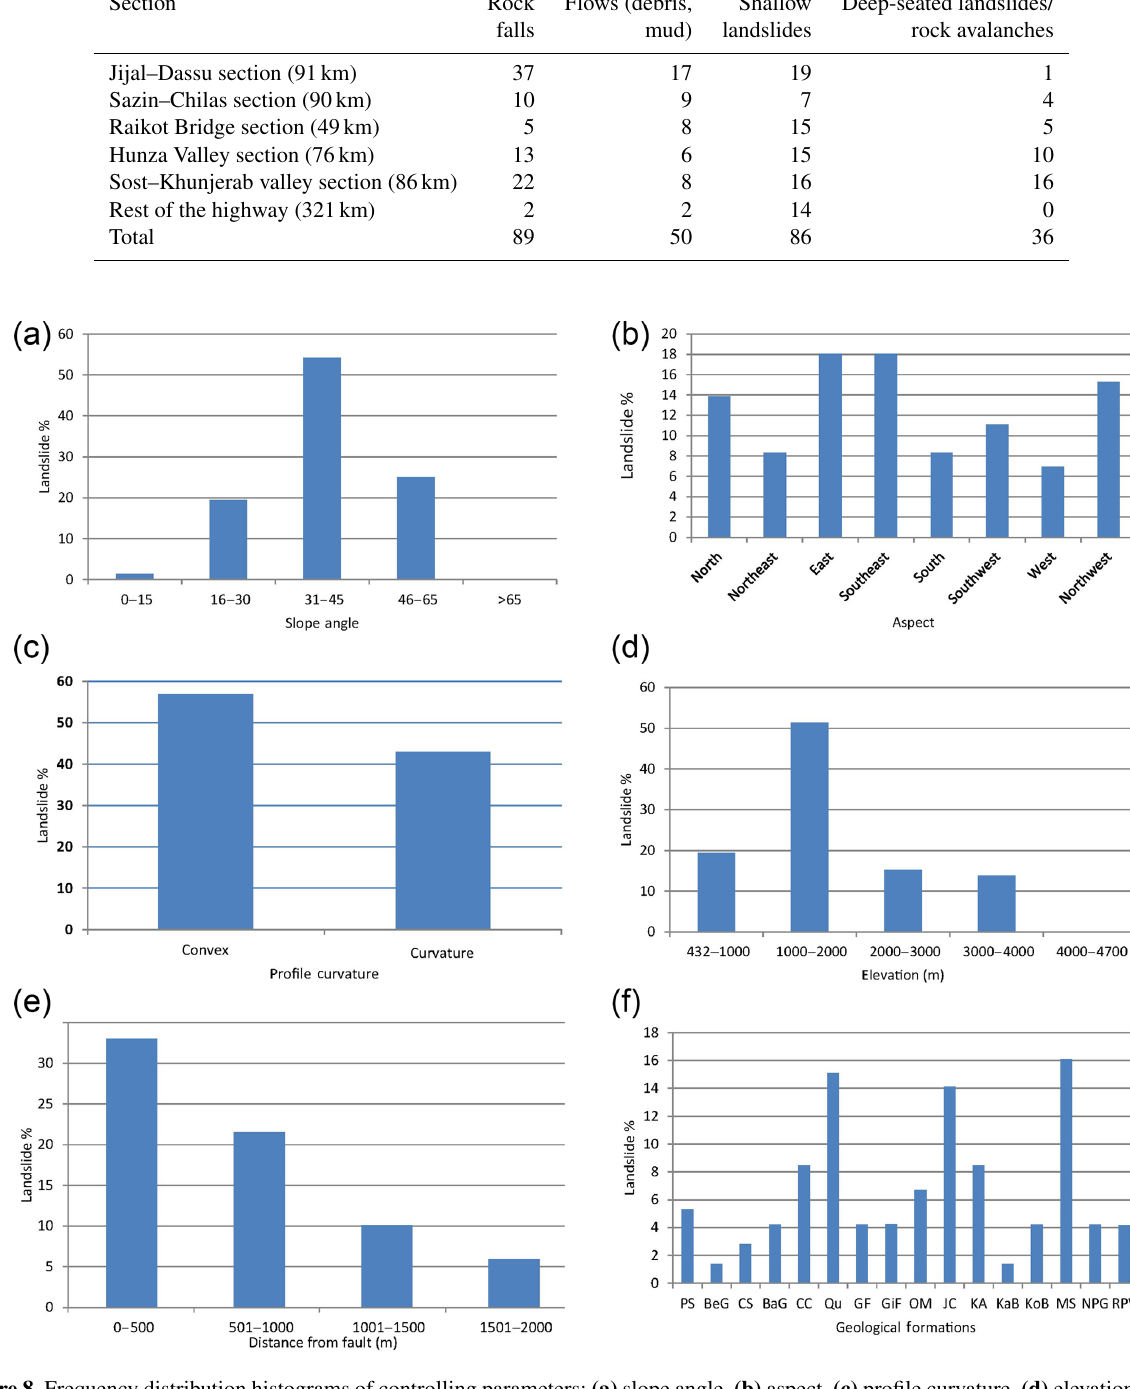
Figure 8. Frequency distribution histograms of controlling parameters: (a) slope angle, (b) aspect, (c) profile curvature, (d) elevation, (e) dis- tance from fault, (f) geological formation (abbreviations explained in Fig. 5). BaG: Baltit Group, BG: Besham Group, Cc:Chilas